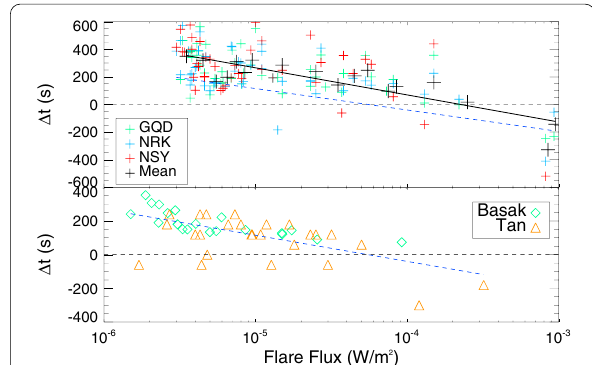
Fig. 5 (cid:31) t vs. flare flux from three transmitter (top panel), and results from BCT (bottom panel). On the top panel, the red line displays the fit of our results, the dashed blue curve is the fit of the BCT data (also reproduced on the bottom panel)